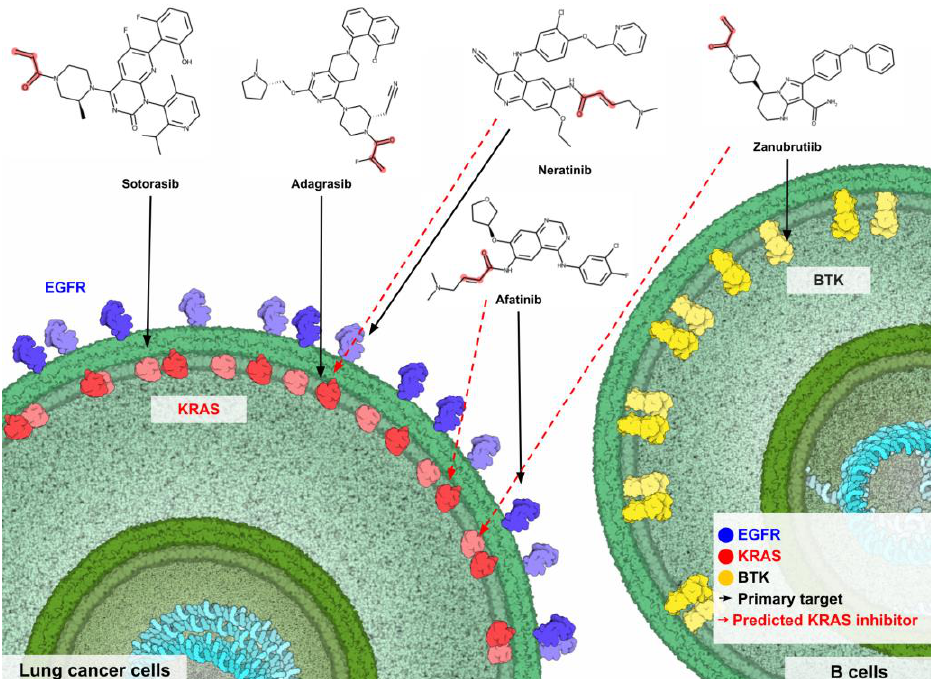
Figure 10. Summary of the newly predicted KRAS G12C inhibitors which included afatinib, neratinib, and zanubrutinib. The EGFR, KRAS G12C , and BTK are represented in blue, red, and yellow protein colors. The black arrows indicate the primary targets of drugs, while the red dotted arrow indicates the newly predicted inhibitors against the KRAS G12C protein. The figure was prepared by using CellPAINT software [45].